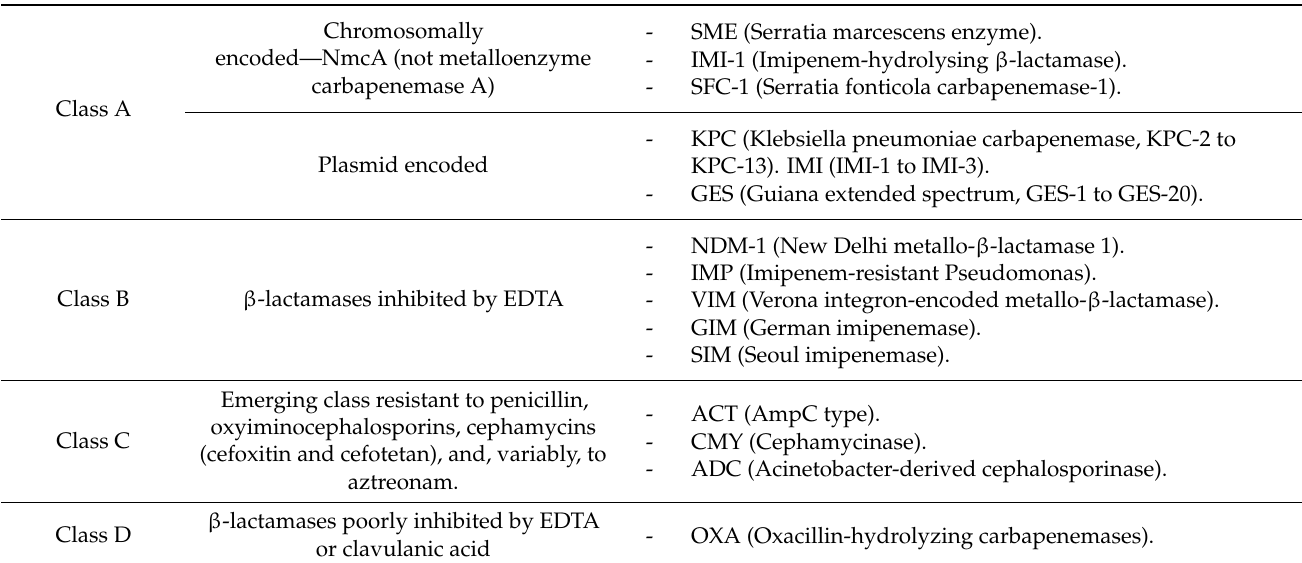
Table 2. Molecular classification of carbapenemase